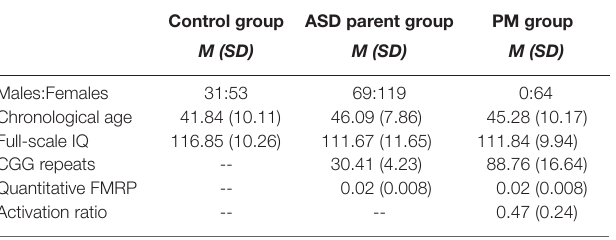
TABLE 1 | Ratio of sex distribution, mean (M), and standard deviation (SD) for chronological age and IQ across groups. Control group ASD parent